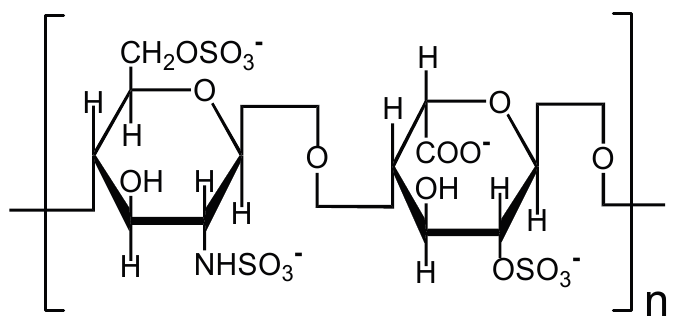
Figure 1. Chemical structure of the disaccharide repeating unit of heparin. ( left ): glucosamine (GlcN); ( right ): L-iduronic acid (IdoA).